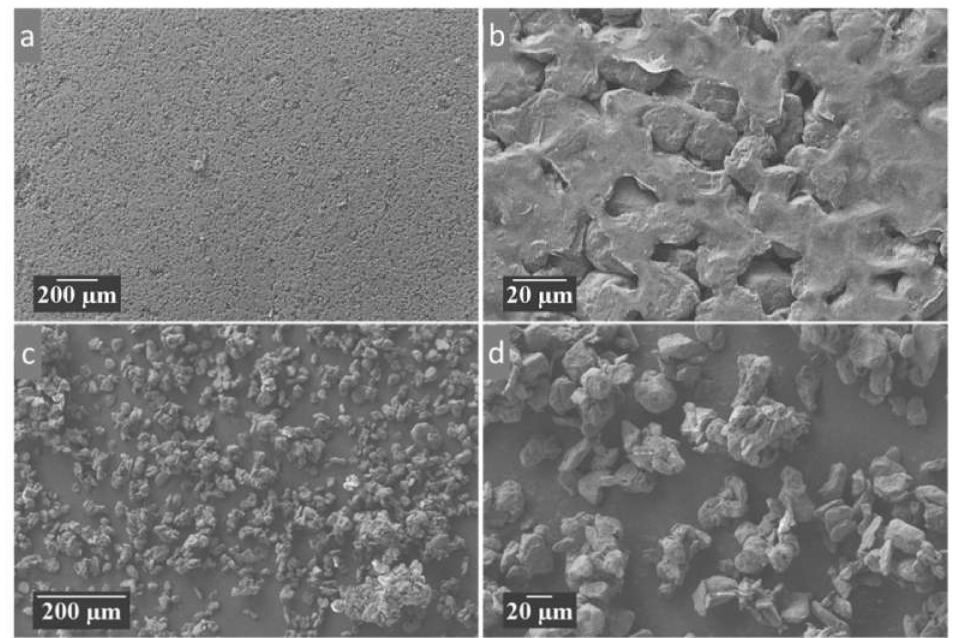
Figure 8. SEM images showing ( a ), ( b ) the anode material after being separated from the copper film ( c ), ( d ) graphite particles from the anode, after the binder is removed by dissolving in NMP (N-methyl Pyrrollidone) followed by